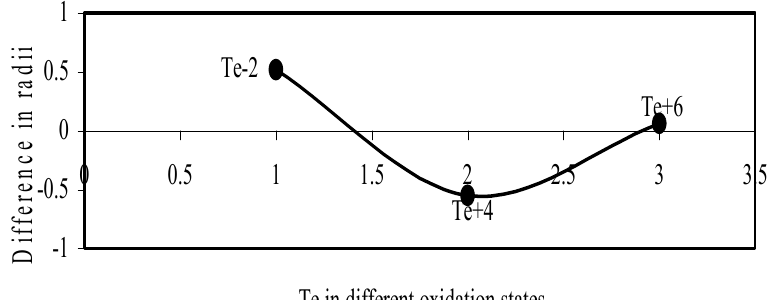
Figure 12. Plot of difference in experimental and theoretical radii of Te in different oxidation states.